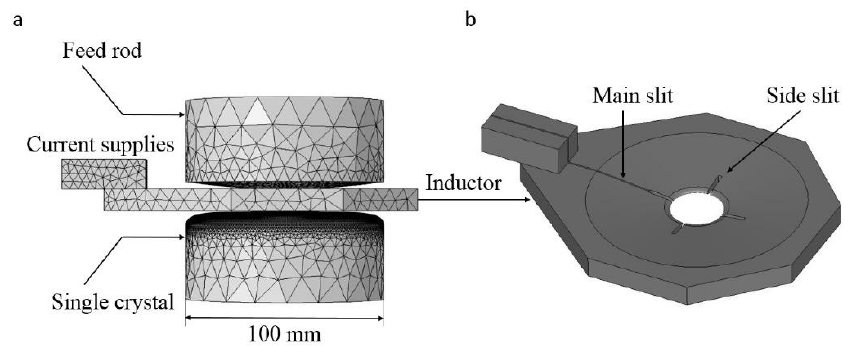
Figure 1. Illustration of simulation model for calculating high-frequency EM field in the FZ method: ( a ) polycrystalline feed rod, single crystal, and inductor; ( b ) high frequency inductor with four slits. The single crystal diameter is 100 mm. The model is constructed with unstructured grids.